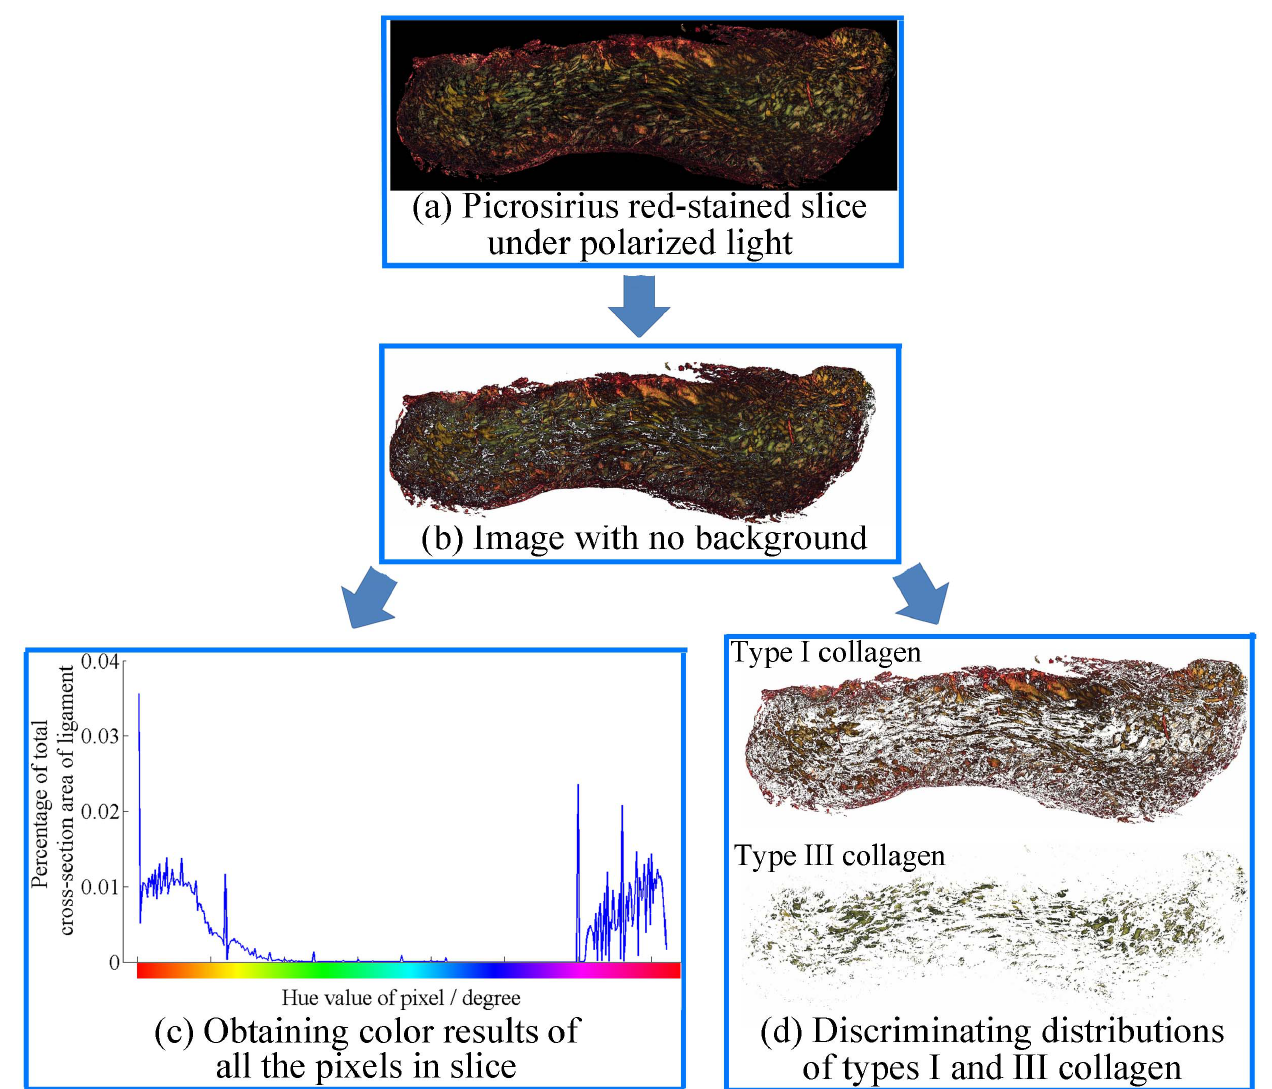
Figure 4. A process flow diagram for differentiating the collagen contents in the histological slice of the mid-substance specimen. Two slices were sectioned at the upper and lower boundaries of each mid-substance specimen, corresponding to the locations that 1 mm far from the mid-position of the ligament, respectively (shown as ‘slice 1 & 2’ in Figure 1). Each slice was firstly stained with 0.1% picrosirius red solutions, and imaged under polarized light (a). Then, the dark background of the image was removed for further image processing (b). The color results of all the pixels in each slice were obtained (c): the type I and type III collagen corresponded to the pixels with red-yellow color (hue values of 345–75 degrees) and greenish color (hue values of 75–165 degrees), respectively. Average collagen ratios were calculated from the collagen content values in the two slices for characterizing each mid-substance specimen. In addition, the distributions of types I and III collagen in the specimen slice were determined by the hue values of the pixels